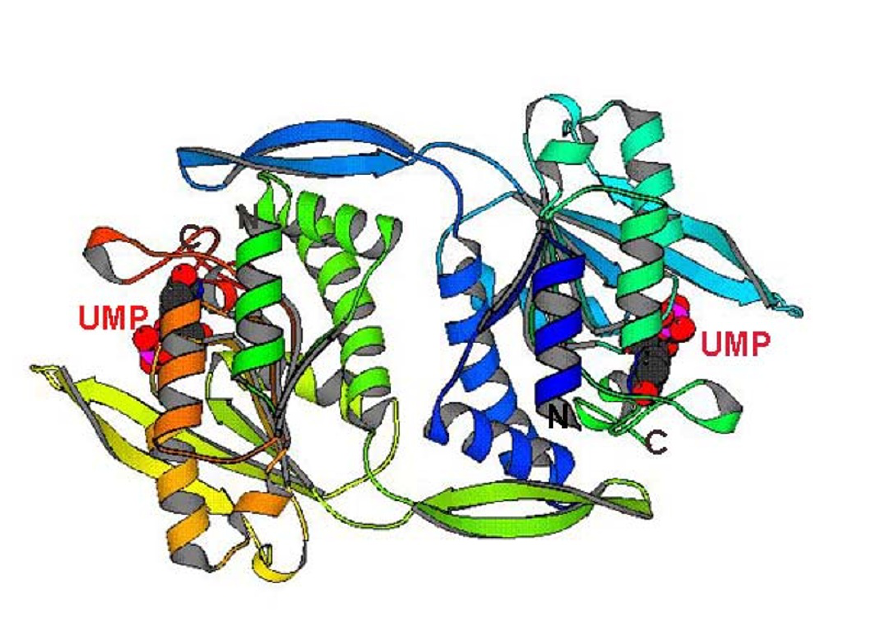
Figure 10 The structure of the predicted dimer derived from SWISSModel for F538. Reaction product – UMP is shown in red. N – and C-termini are indicated.